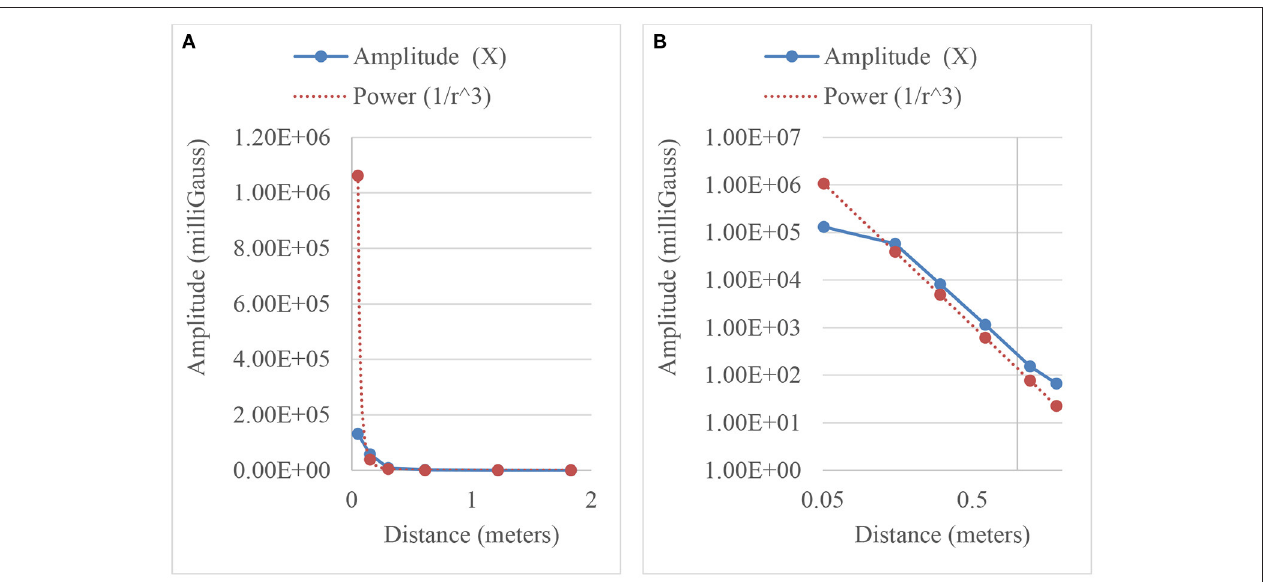
FIGURE 7 | Comparison of experimentally observed (X-axis) and theoretical near-field values in air using HMR2300 magnetometer. (A) Shows results using base-10, while (B) uses a log-log